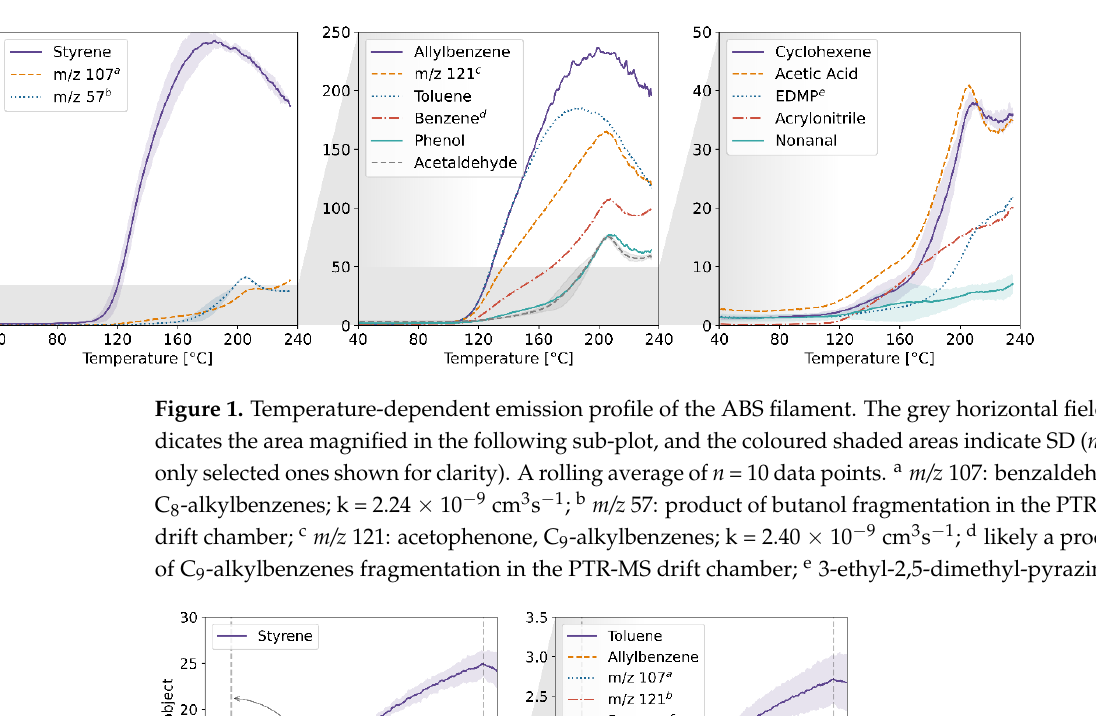
Figure 3. Temperature-dependent emission profile of the ASA filament. The legend in subplot 3 is arranged from highest to lowest emission at 240 °C. a,b,c see Figure 1 caption; d acetophenone, C 9 - alkylbenzenes; k = 2.40 × 10 −9 cm 3 s −1 ; e unidentified; k = 2.0 × 10 −9 cm 3 s −1 ; f α -methylstyrene, phe- nylpropene; k = 2.0 × 10 −9 cm 3 s −1 ; g tert-butyllbenzene, p-propyltoluene; k = 2.0 × 10 −9 cm 3 s −1 .